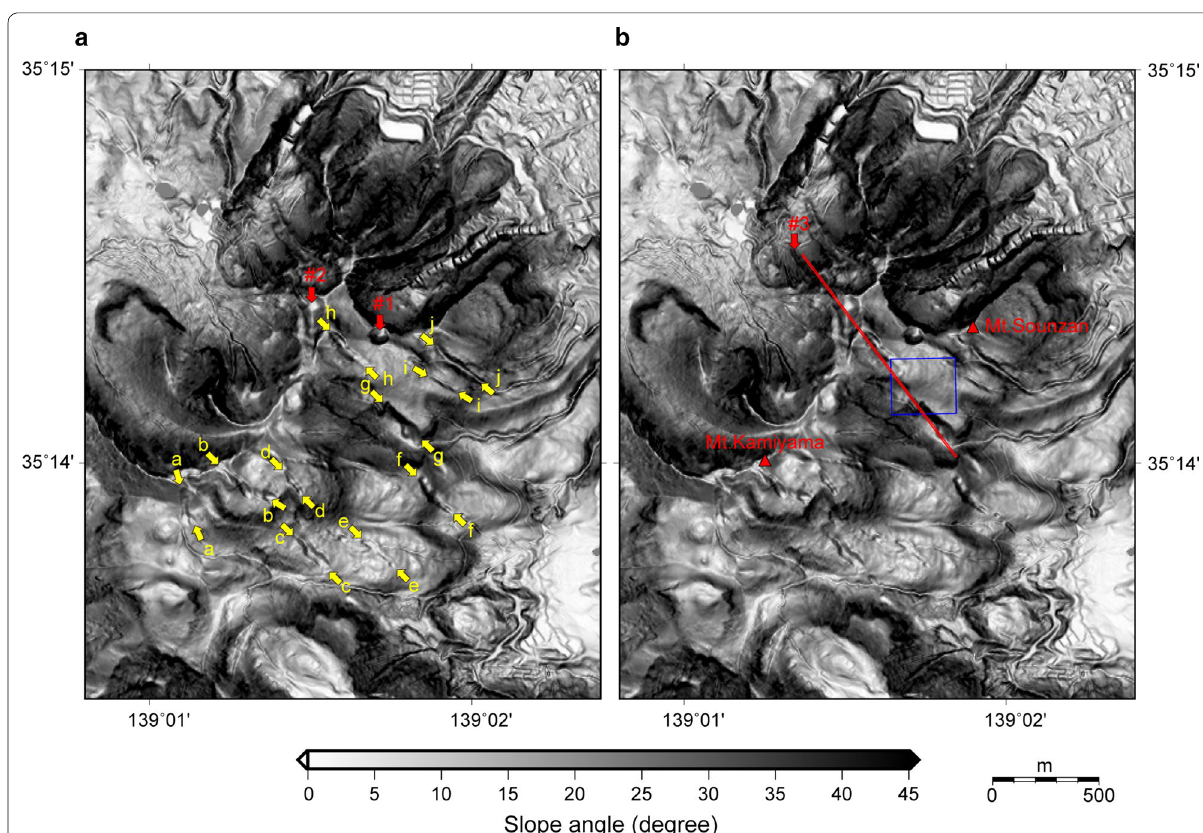
Fig. 9 Relation between the open crack and the landform. The base map is a slope gradation map made from the 5 m DEM released by the GSI. Yellow and red arrows show fissure and crater, respectively. a Distribution of fissures and craters that formed by past volcanic activities. Fissures a, b, c, g, and h, and craters #1 and #2 correspond to the fissures and craters detected by Kobayashi (2008). b Location of the open crack and deflation sill models estimated by the model inversion. The red line and blue rectangle show the location of the estimated open crack and sill, the parameters of which are listed in Table 3. Crater #3 is the location of craters formed by the 2015 phreatic eruption (Mannen et al.